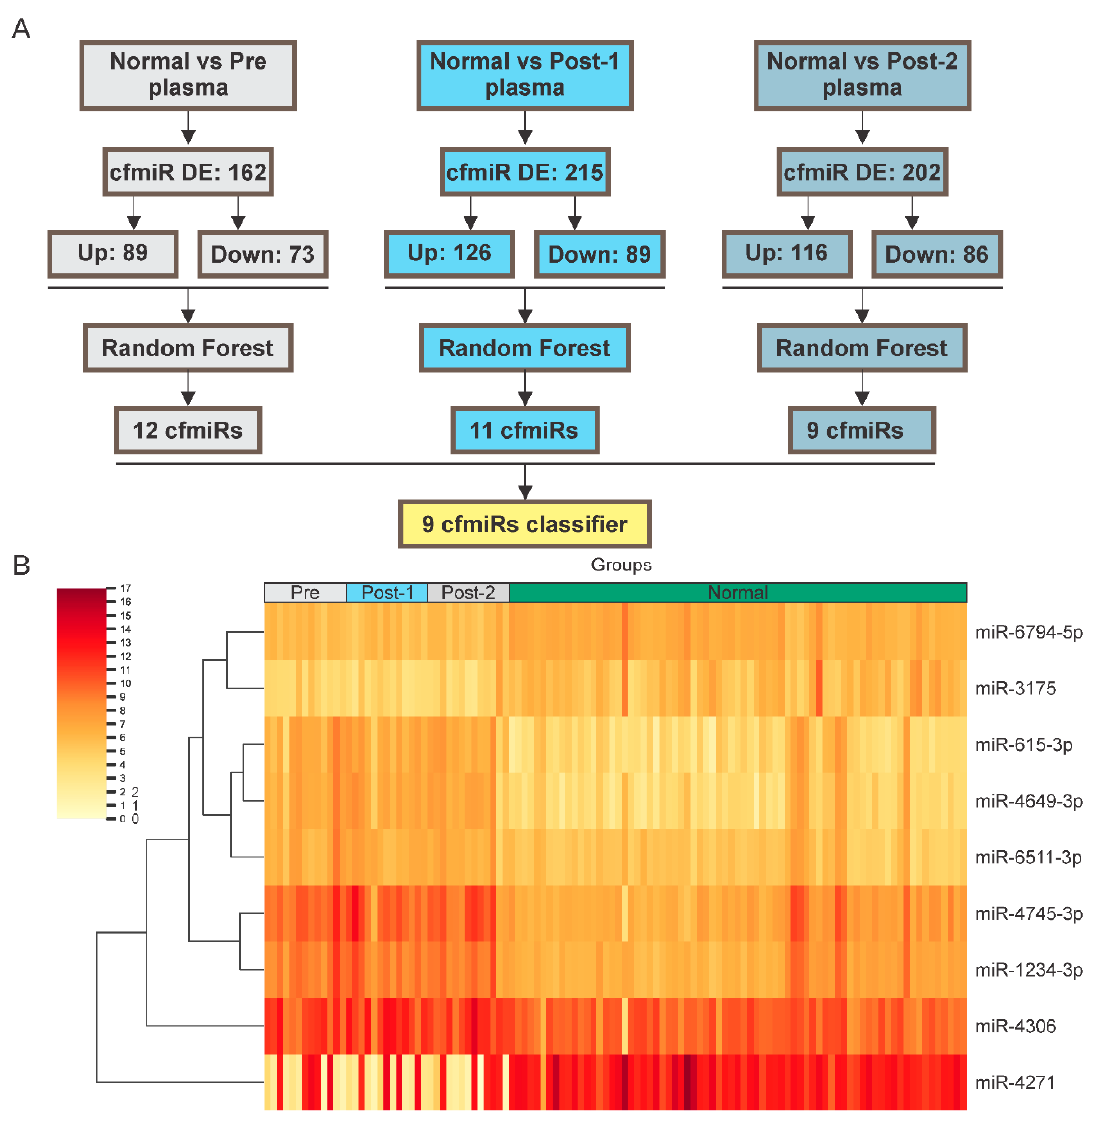
Figure 2. Identification of DE cfmiRs in normal donors’ and melanoma patients’ plasma samples ( A ) Shown are the DE cfmiRs in normal plasma samples versus pre- and post-treatment (Post-1 and Post-